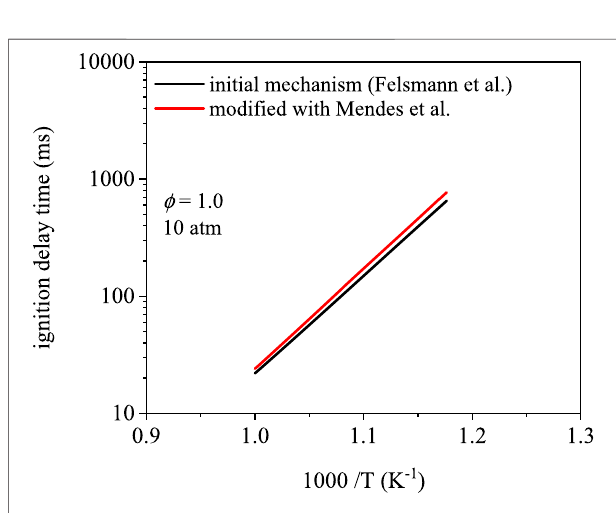
FIGURE 7 | Ignition delay time simulations using the mechanism from Felsmann et al. (Felsmann et al., 2017) and a modi fi cation using site-speci fi c rates from Mendes et al. (Mendes et al., 2014). Ignition delay times differ by nearly 20% at 850 K and 10% 500 K.